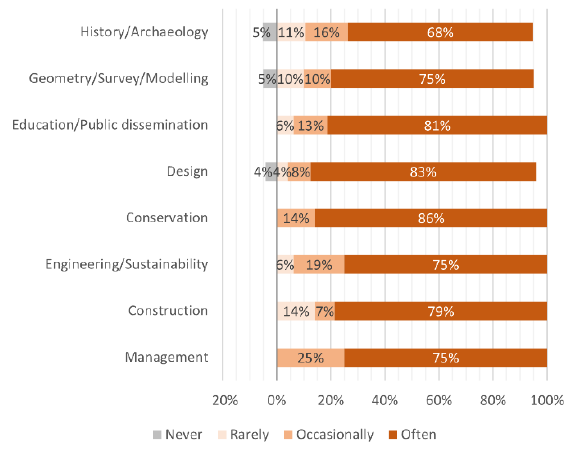
Figure 19: Access needed for geometric data by the different